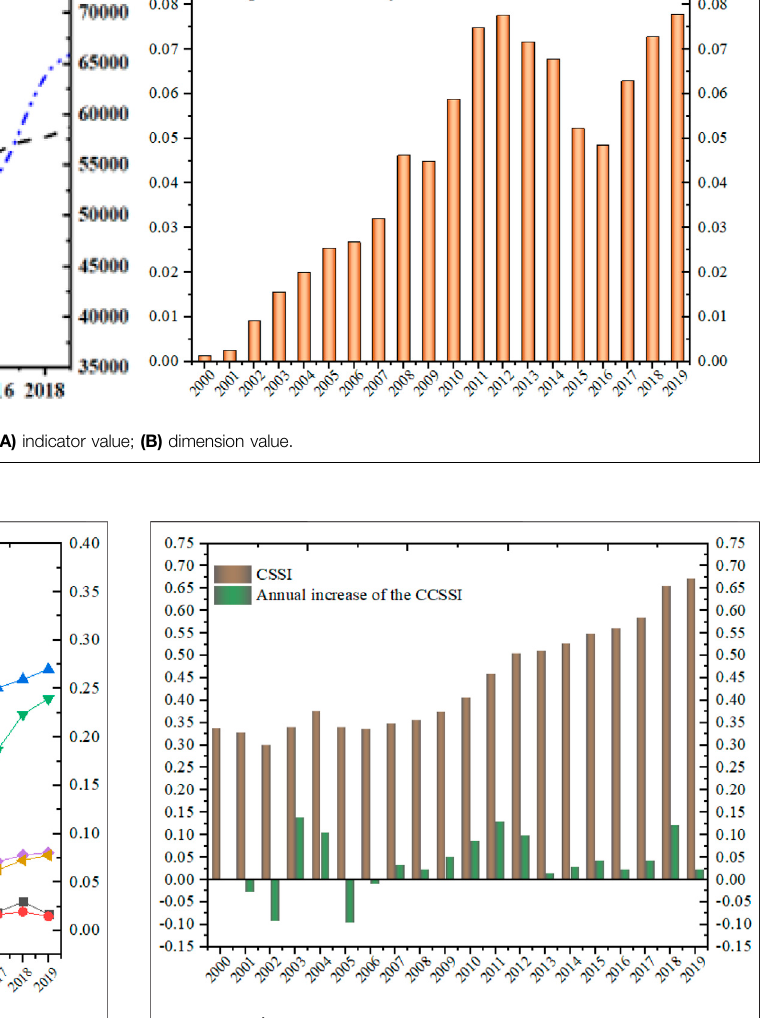
FIGURE 10 | Comparison of different dimensions values between 2000 and 2019.